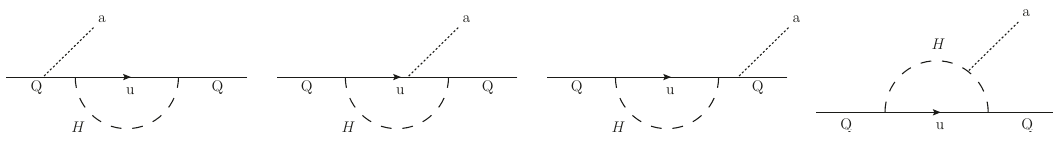
Figure 1 . One-loop diagrams for the running of c